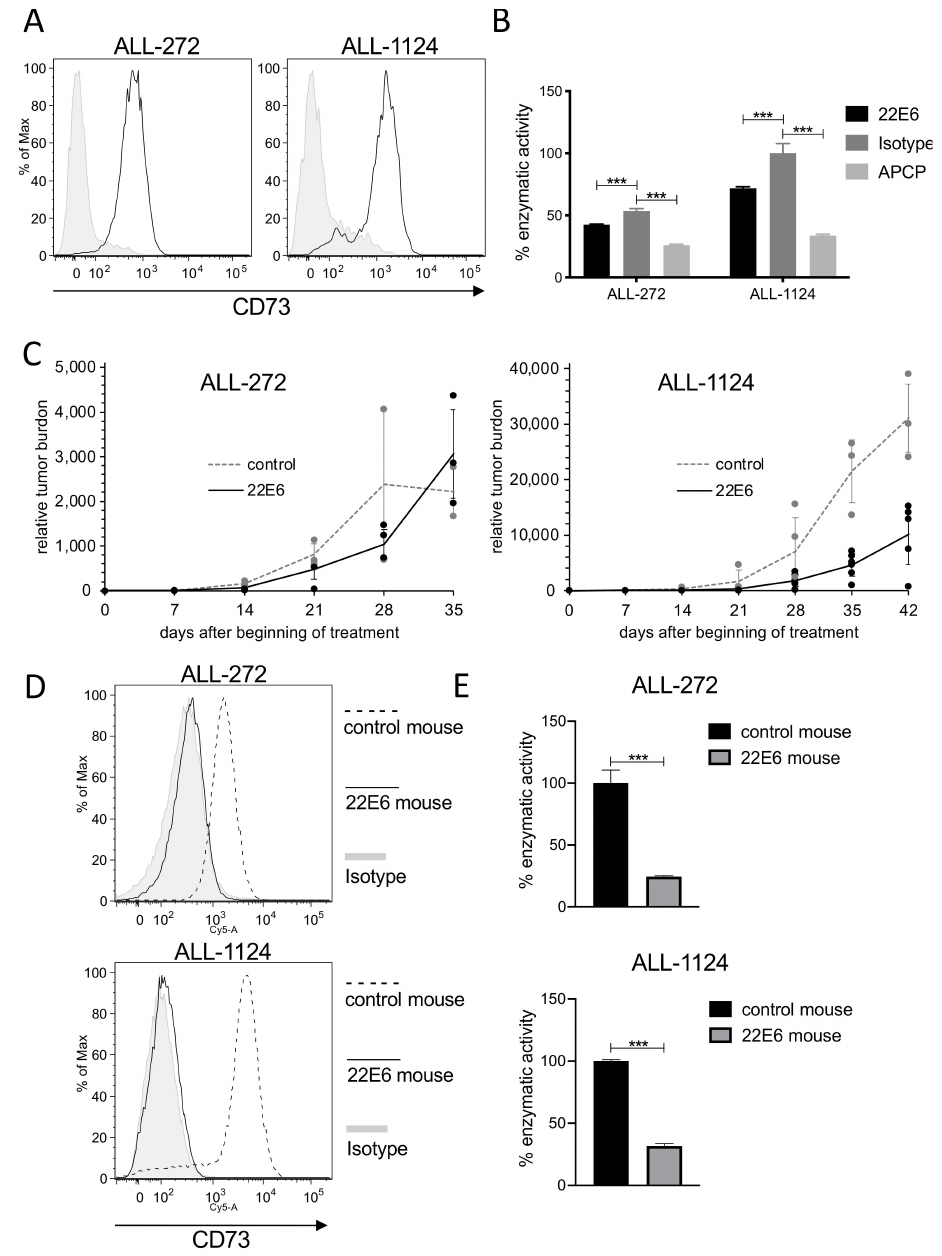
Figure 7. 22E6 induces downregulation of CD73 on PDX ALL cells in vivo. ( A ) PDX ALL cells express surface CD73 before transplantation. Black line = 22E6; tinted histogram = isotype control. ( B ) CD73 on PDX ALL cells is enzymatically active, and this activity can be inhibited with 22E6 and APCP. ( C ) NSG mice were transplanted with ALL-272 or ALL-1124 cells. Tumor burden was monitored by bioluminescence imaging (BLI). Mice were treated with 100 µ g 22E9 twice per week ( n = 5 for ALL-272, n = 6 for ALL-1124; black triangles) or left untreated ( n = 3 for ALL-272, n = 4 for ALL-1124; grey dots). Tumor burden (BLI signal) relative to treatment start was calculated. Data of two independent experiments were integrated. Shown are individual mice (dots) as well as mean ± standard deviation (line). Tumor burdens of ALL-1124 between control and 22E6 treated mice differed significantly at days 35 ( p < 0.05) and 42 ( p < 0.01). At high tumor burden, mice were sacrificed, and cells were isolated. ( D ) Flow Cytometric analysis of isolated xenograft ALL cells from 22E6 treated (solid line) and control mice (dashed line) checking for expression of CD73. Black line = 22E6 anti-CD73; Tinted = control. ( E ) AMPase assay with ALL cell lines testing for enzymatic activity of CD73 of isolated xenograft ALL cells from 22E6 treated and control mice. *** p <